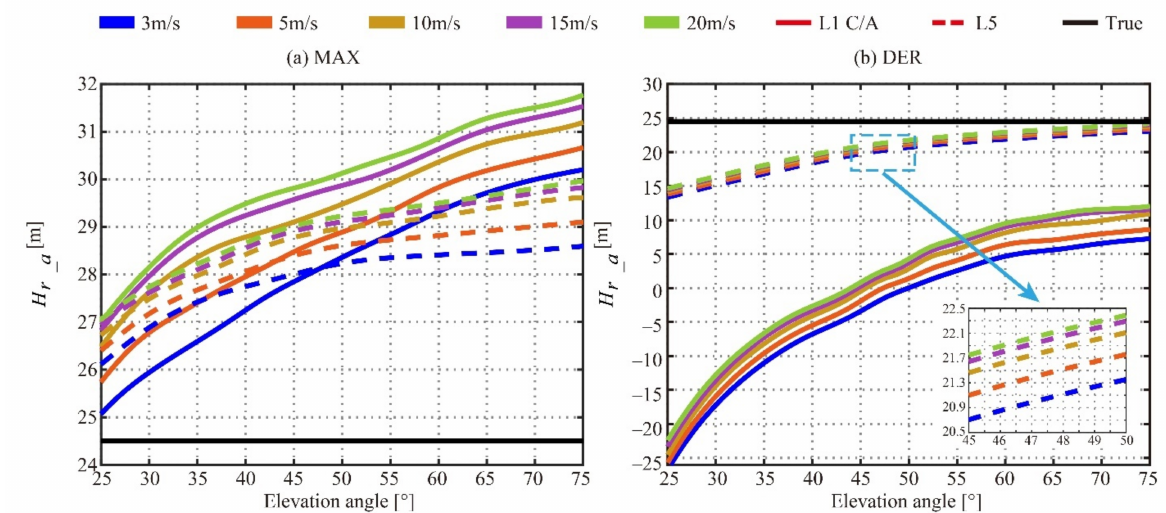
Figure 2. Curves of the height of coastal receiver relative to the sea surface versus the elevation angle for different wind speeds and signals, obtained from the Z-V model using the MAX method ( a ) and the DER method ( b ) for GPS L1 C/A signal (solid line) and GPS L5 signal (dotted line). The true height is 24.5